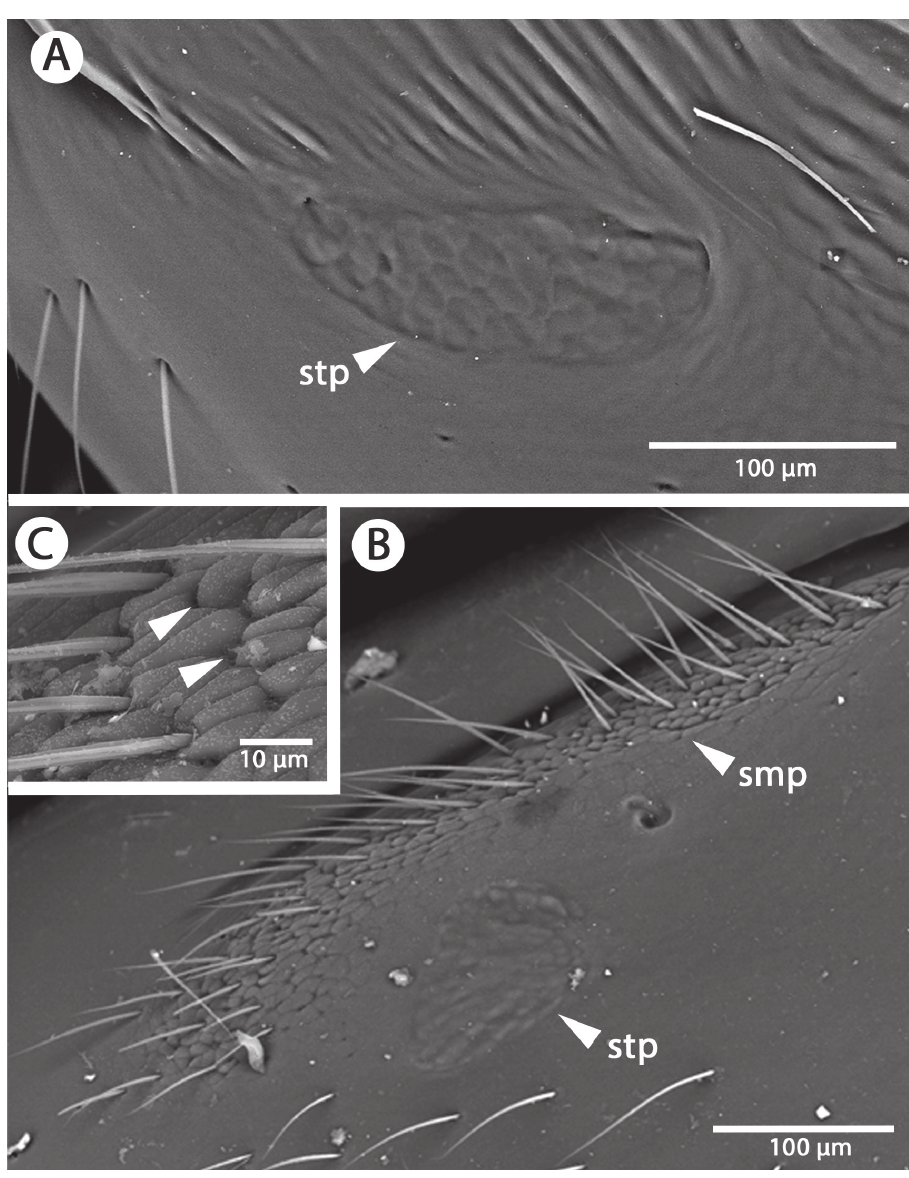
Figure 2. SEM images of the syntergal and synsternal translucent patches and synsternal setiferous patches in male Megaspilus armatus Say, 1836 (Hymenoptera: Megaspilidae) specimens. A Dorsal surface of the metasoma, showing the scutes (identifier PSUC_FEM 68527) B Ventral surface of the metasoma (identifier: PSUC_FEM 50127) C Closer view of the synsternal setiferous patch and scutes, with arrows pointing to pore openings in the cuticle (identifier: PSUC_FEM 50127) Abbreviations: smp = synsternal setiferous patch; stp = synsternal translucent